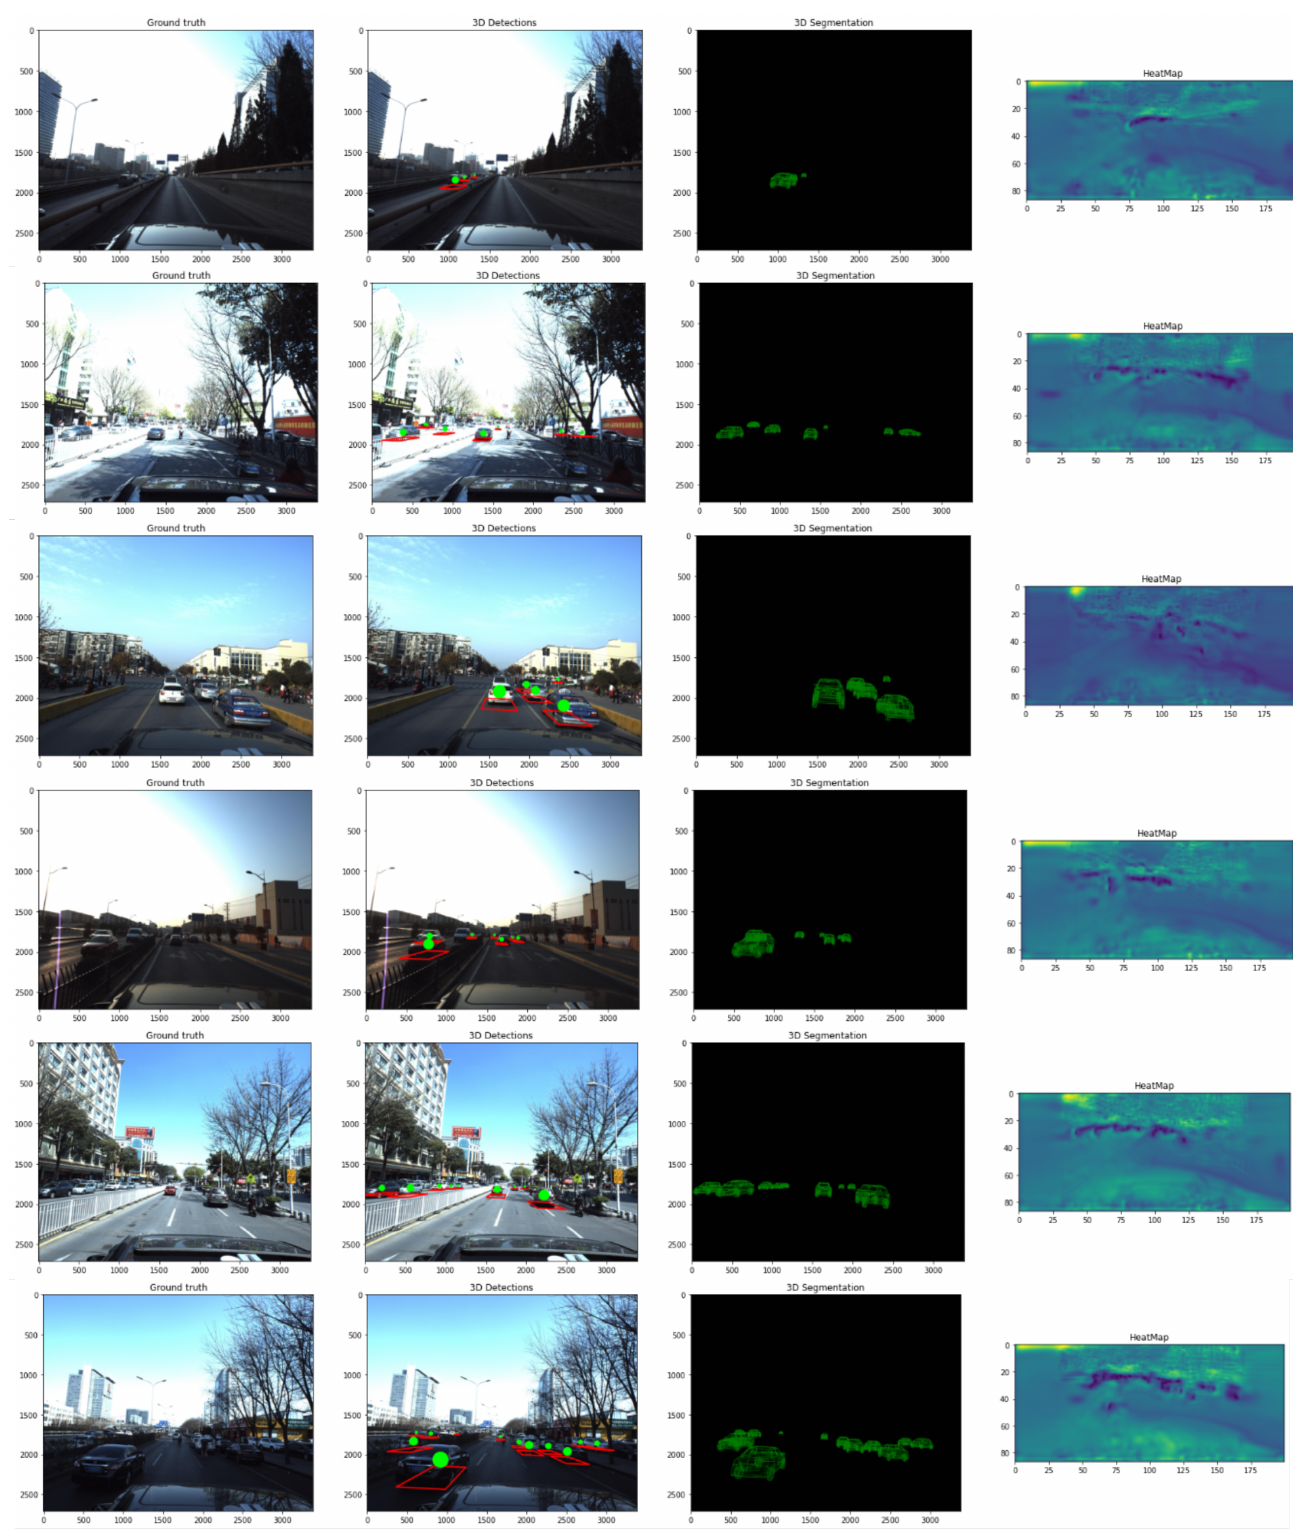
Figure 13. Visualization of results got by the proposed model over the test images from Apollo Car 3D dataset. From left to right (input image, 3D detection, 3D models substituted, and